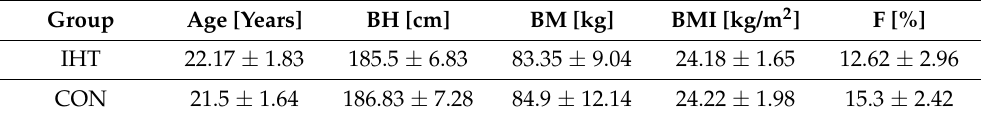
Table 1. Selected somatic indicators of the examined competitors. Group Age